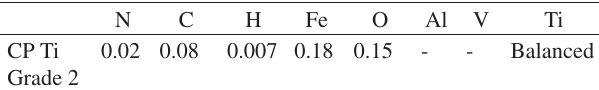
Table 1. CP Ti composition (%).